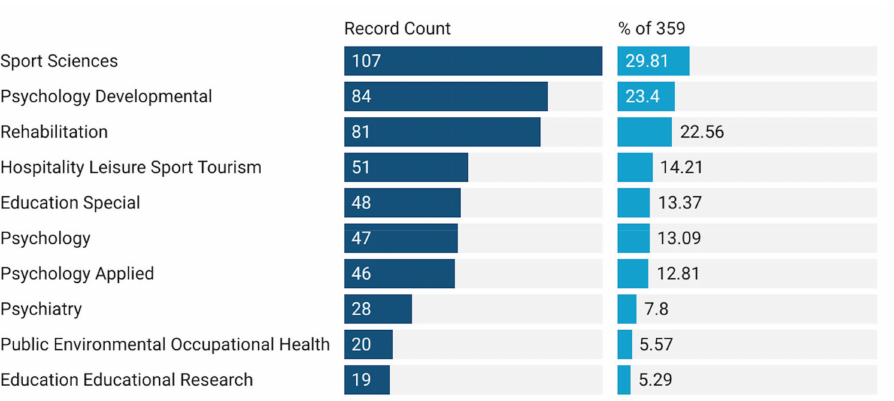
Figure 3. Top 10 categories of PA research of ASD in WoS.